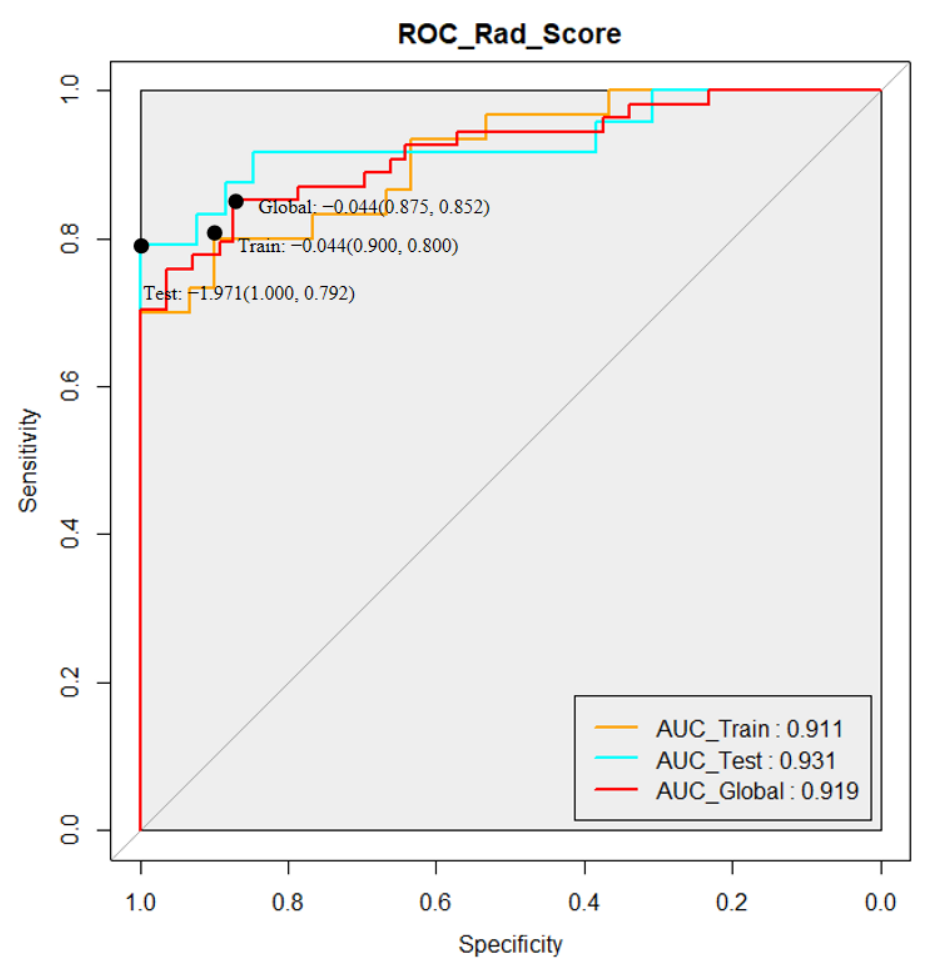
Figure 5. Sensitivity and specificity of the radiomic model. Data was represented as Rad_score (specificity, sensitivity).